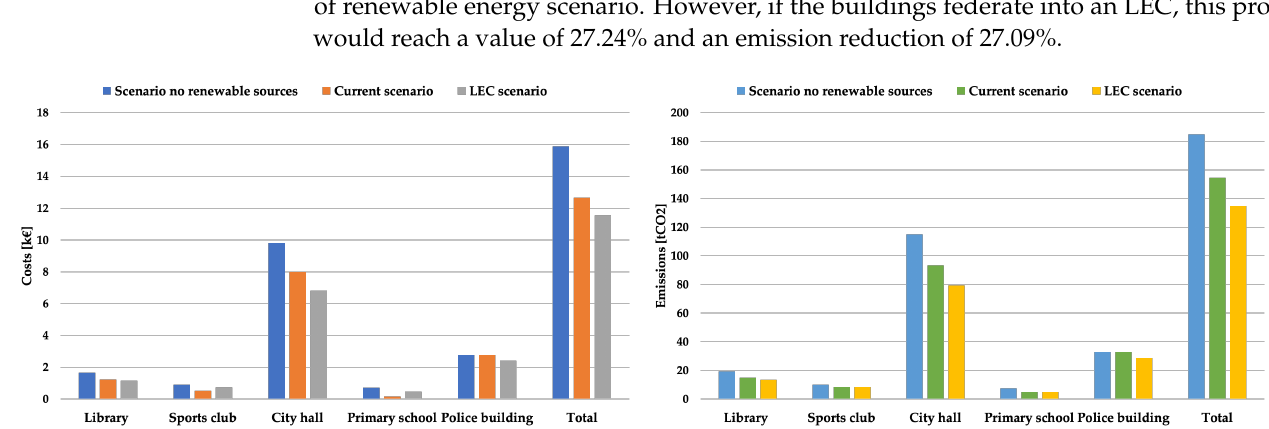
Figure 7. Economic and environmental impact of the existing infrastructures in the no renewable, current, and EC scenario.